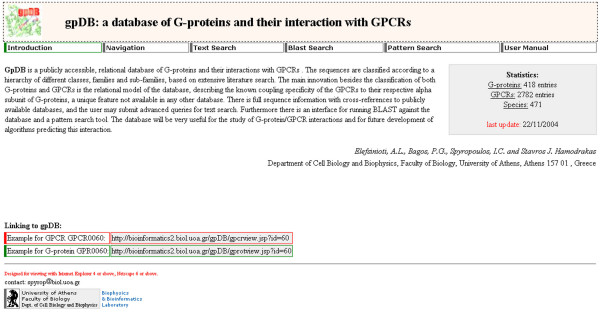
The Home page of the database A snapshot of the database's homepage. The main menu is shown with the available links for the tools, and the user's manual.